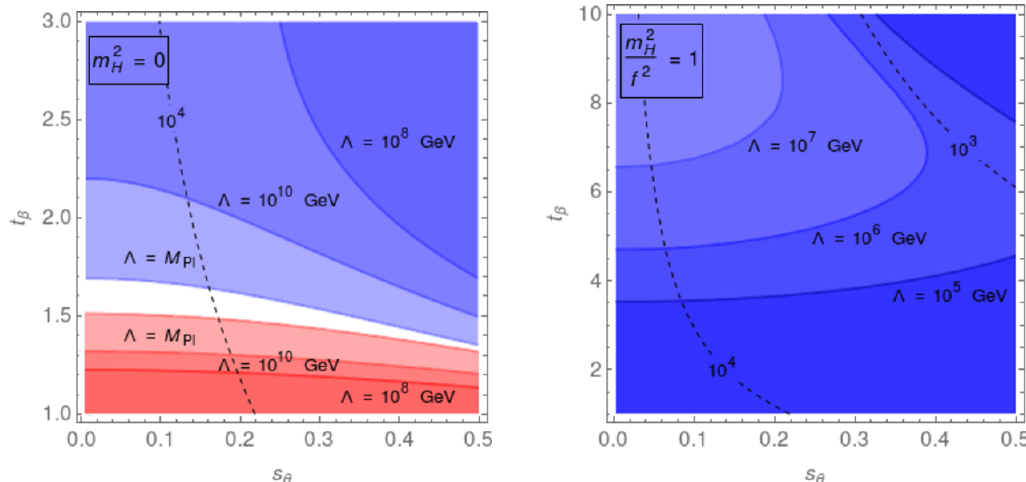
Figure 3 . The blue (red) regions illustrate the vacuum instability (non-perturbativity) scale. The dashed lines show the values of (cid:3) TC = 4 (cid:25)f in GeV. Left panel: m 2